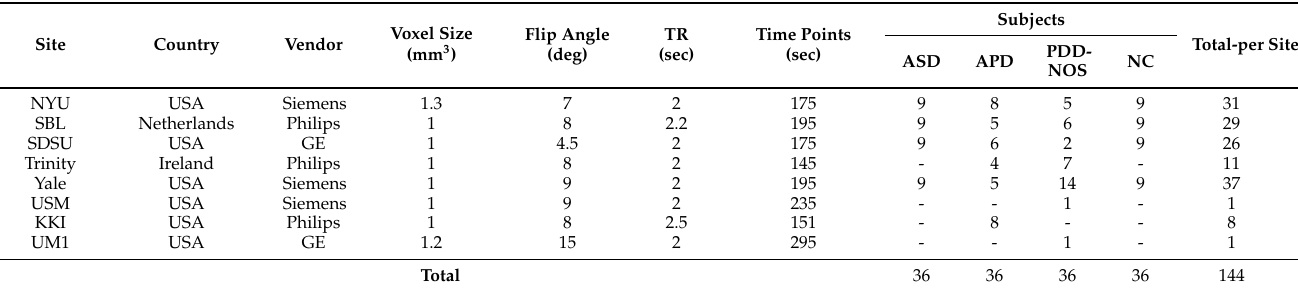
Table 1. Details fMRI ASD subtypes and NC dataset from ABIDE database, acquired using 3T MRI scanner.